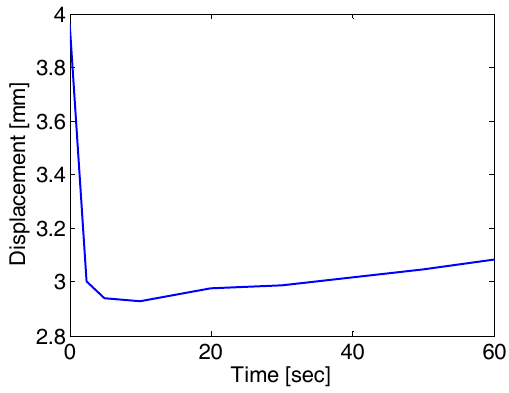
Figure 5. Punch holding time effect on springback.